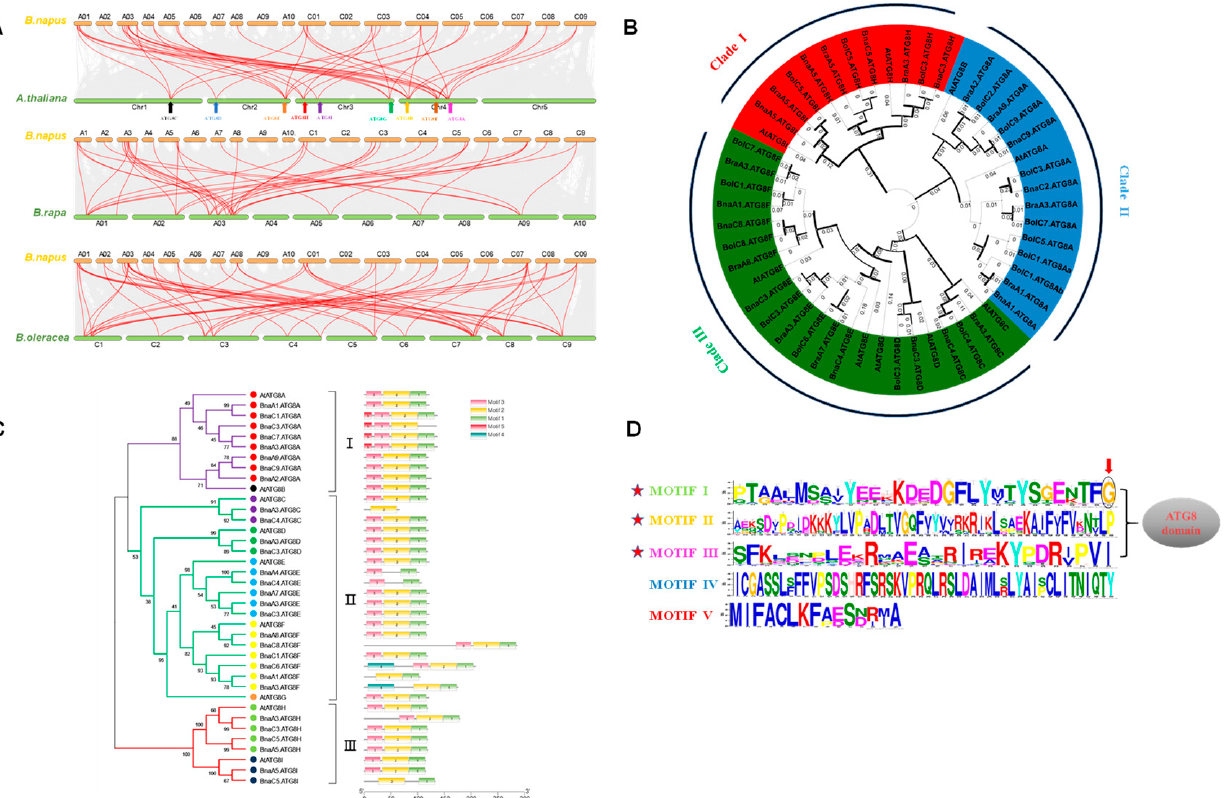
Figure 1. Identification and bioinformatics analysis of ( Autophagy-related gene 8 ) ATG8 Gene family in Brassica napus . ( A ) Syntenic analysis of the ATG8 family genes in A. thaliana , B. rapa , B. oleracea , and B. napus ( B ) Phylogeny analysis of the ATG8 genes in A. thaliana and Brassica crops. ( C , D ) Identification and characterization of the conserved motifs in the ATG8 proteins in A. thaliana and B. napus . Molecular identification ( C ) and sequence characterization ( D ) of the conserved motifs in the ATG8 proteins in A. thaliana and B. napus. L. In C, the boxes with different colors indicate different conserved motifs (motifs 1–5), and black lines represent the ATG8 protein regions without detected motifs. In D, the larger the fonts, the more conserved the motifs. Among them, the tagged motifs were identified as the ATG